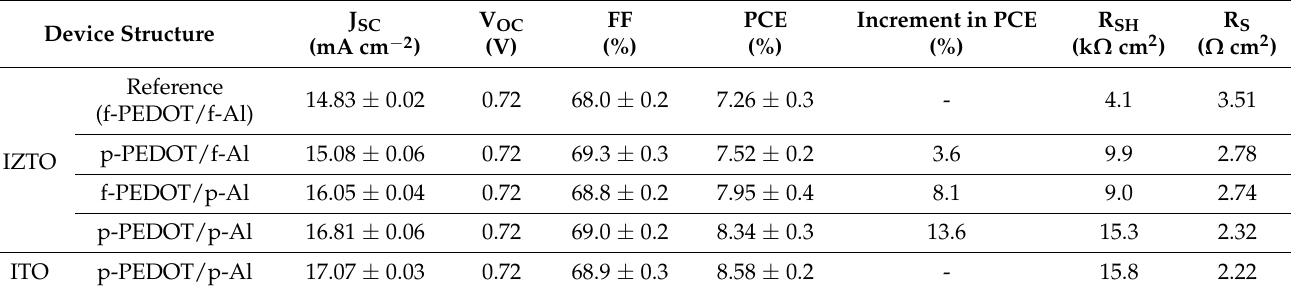
Table 1. Device characteristics of various device structures. The average values were calculated from eight or more cells. R SH and R S were obtained from the slope of the J-V curves in the dark at 0 and 1 V, respectively. Device